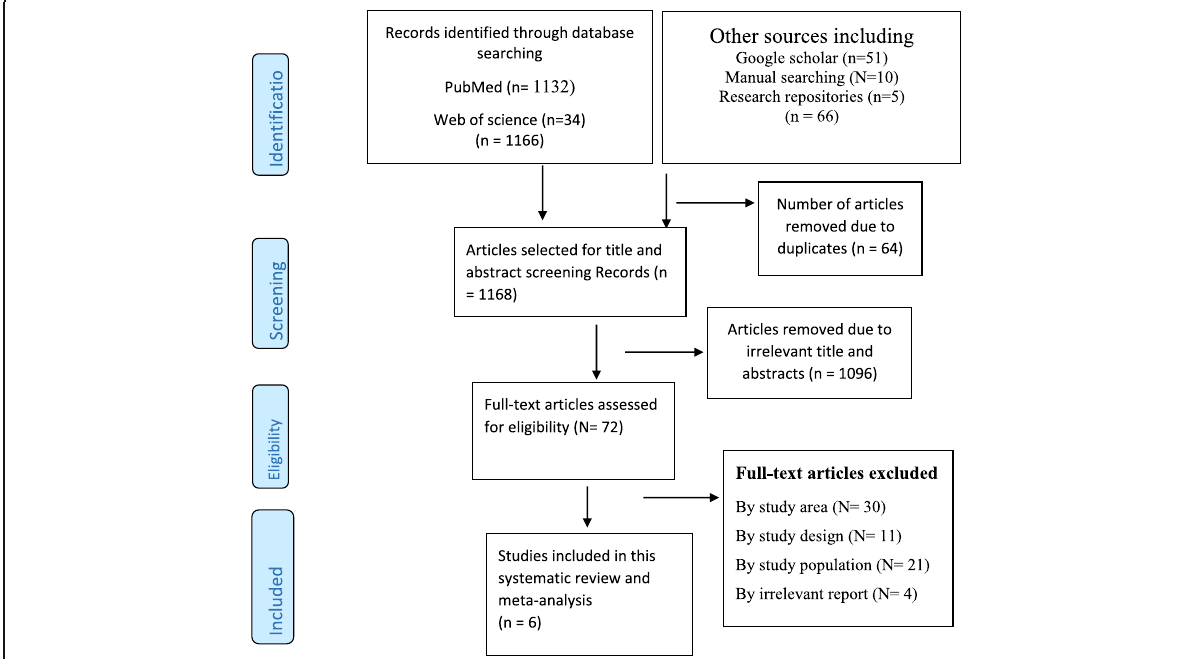
Fig. 1 Flow diagram of articles selection and